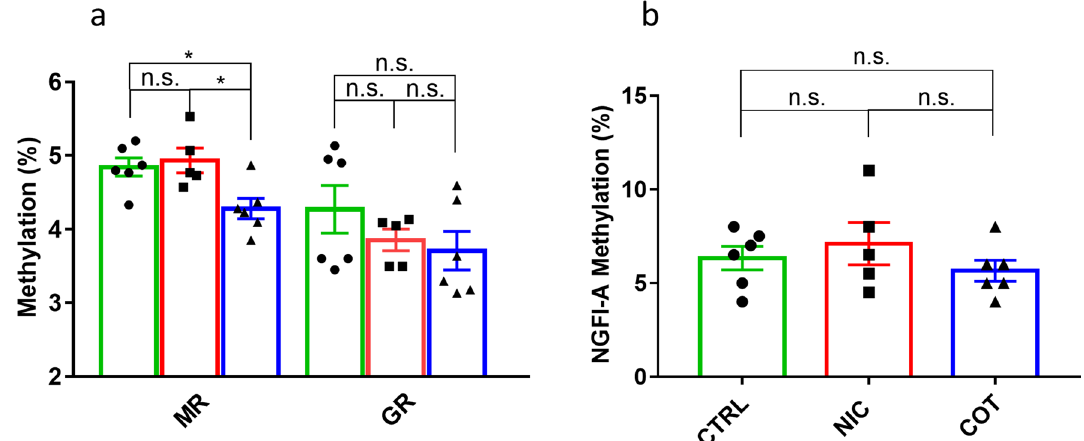
Figure 6. DNA methylation analysis of hippocampal corticosteroid receptors. Panel ( a ) shows the mean % DNA methylation status of hippocampal GR (Nr3c1) and MR (Nr3c2) genes. Panel ( b ) shows the mean % DNA methylation status of the NFGI-A binding site, a specific sequence present on the GR gene. All data refer to adult male mice perinatally exposed to nicotine (NIC, n = 5), cotinine (COT, n = 6) or just the vehicle (CTRL, n = 6). * p (adjusted for multiple comparisons) < 0.05; n.s., not